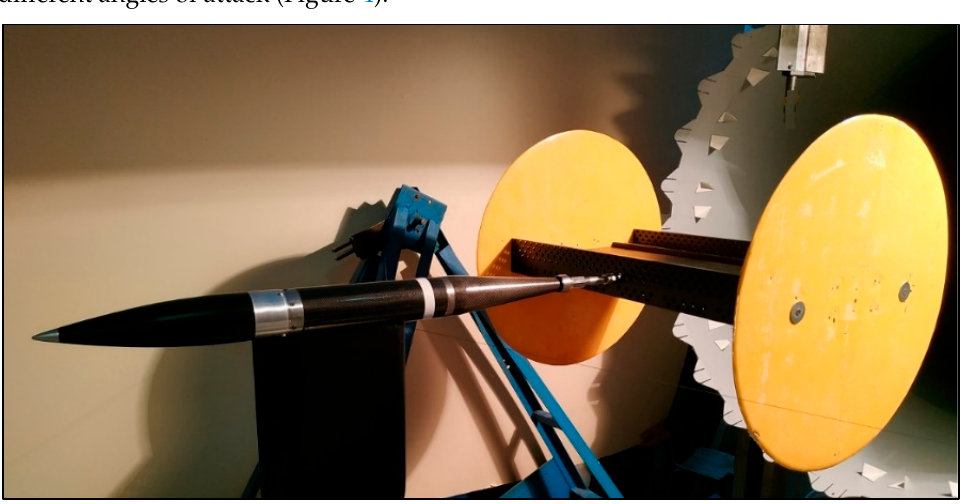
Figure 4. The sectional models on the strain-gauges balances.